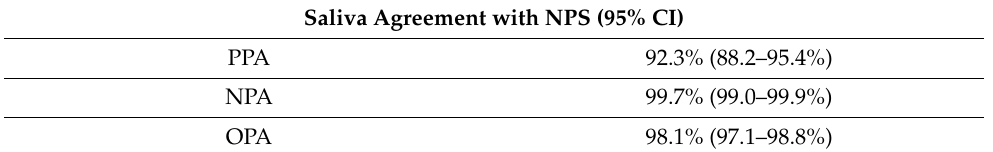
Table A3. Agreement values: Adults.